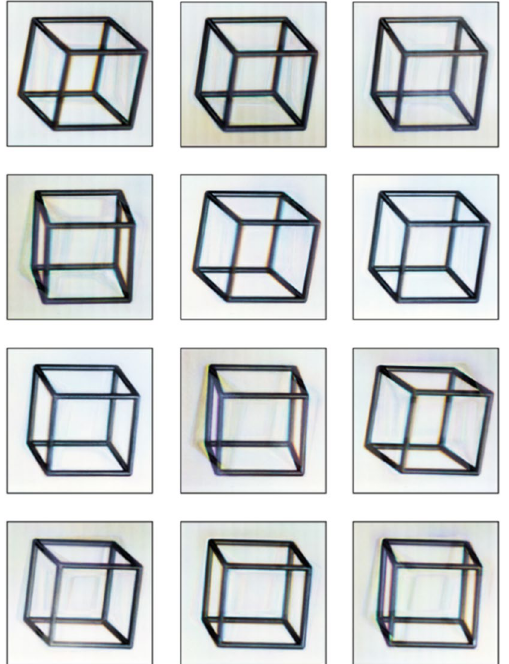
Figure 11. 3D images of the cube at different angles (see Supplementary Video S1 and Supplementary Video